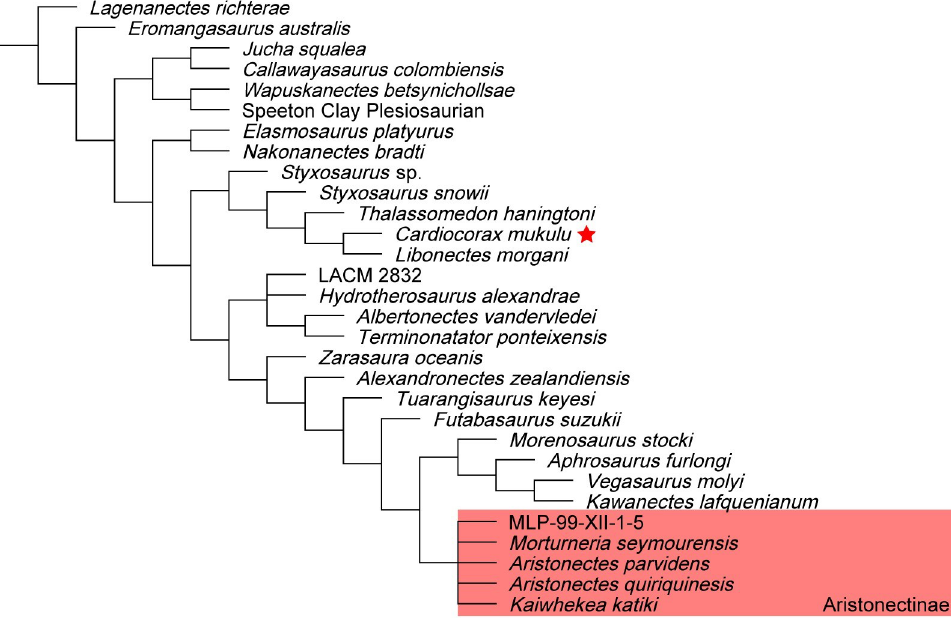
Fig 30. Analysis 3: Consensus tree of Elasmosauridae from implied weighting analysis. (K = 12). Symmetric resampling values were all below